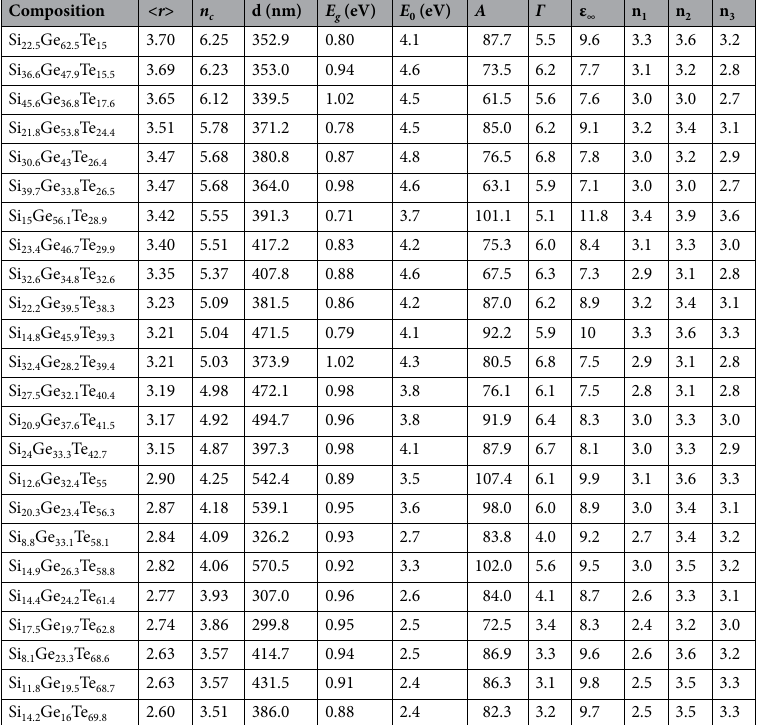
Table 1. Computed values of < r > and n c from topological constraint theory and spectroscopic ellipsometry modelling parameters for the combinatorial library. The average coordination number, < r >, and the average number of constraints, n c , computed for the prepared compositions. Composition was determined using RBS measurements (< 3 at%). From spectroscopic ellipsometry analysis, the thickness (± 0.5 nm), E g (± 0.01), E 0 (± 0.02), A (± 1.0), Γ (± 0.1), ε ∞ (± 0.02) and the values of the refractive indices at 405 nm (n 1 ± 0.03), 587.6 nm (n 2 ± 0.03) and 1550 nm (n 3 ± 0.03) are tabulated (the given errors are the highest resulted from the fitting procedure).